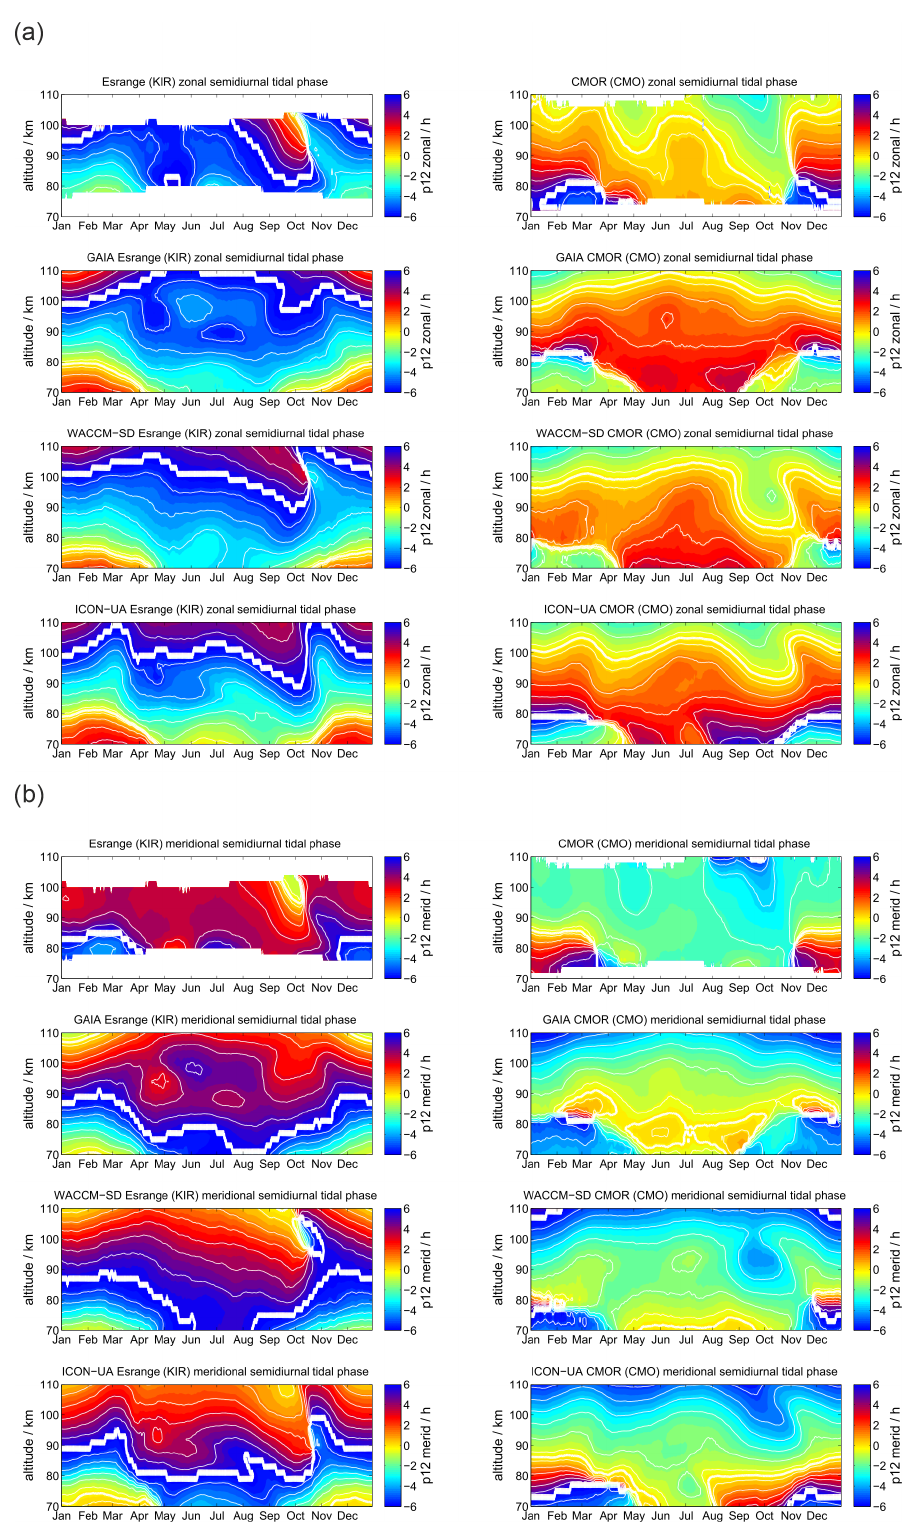
Figure A6. The same as Fig. 2, but for the semidiurnal tidal phases above KIR and CMO.